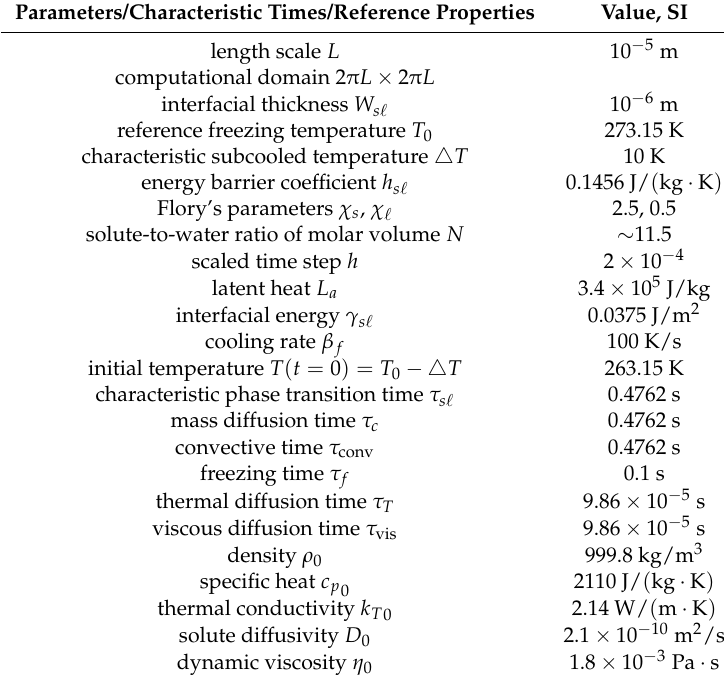
Table 1. Parameters, characteristic time scales, and reference properties for ice crystal and supercooled water used in the test cases. Parameter N is approximated by sucrose in water solution.